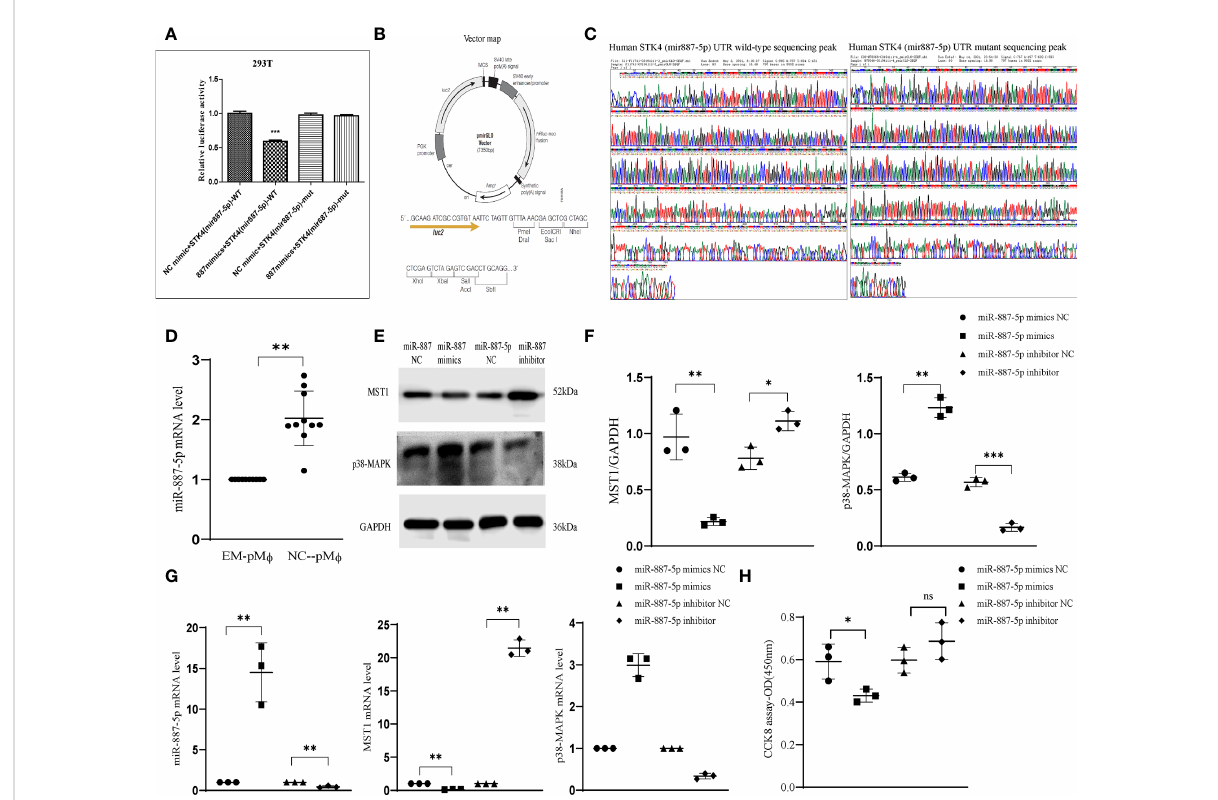
FIGURE 2 miRNA-887-5p increased in peritoneal macrophages of endometriosis. (A) Dual-luciferase reporter assay was conducted in 293T cells co- transfected with miR-NC or miR-887-5p. (B) Vector construction for luciferase experiment. (C) MST1 (STK4)-miR-887-5p UTR sequencing peak. (D) The mRNA levels of miR-887-5p in human peritoneal macrophages with or without endometriosis by RT-qPCR. (E, F) Representative western blot of protein expression after transfection. (G) The mRNA level of MST1 and p38-MAPK after miR-887-mimics and -inhibitor transfection. (H) The cell viability of THP-1 after transfection. *P < 0.05, **P < 0.01, ***P < 0.001 (Control group peritoneal macrophages vs. endometriosis group peritoneal macrophages). Values represent the mean ± standard error. ns means not statistically signi fi